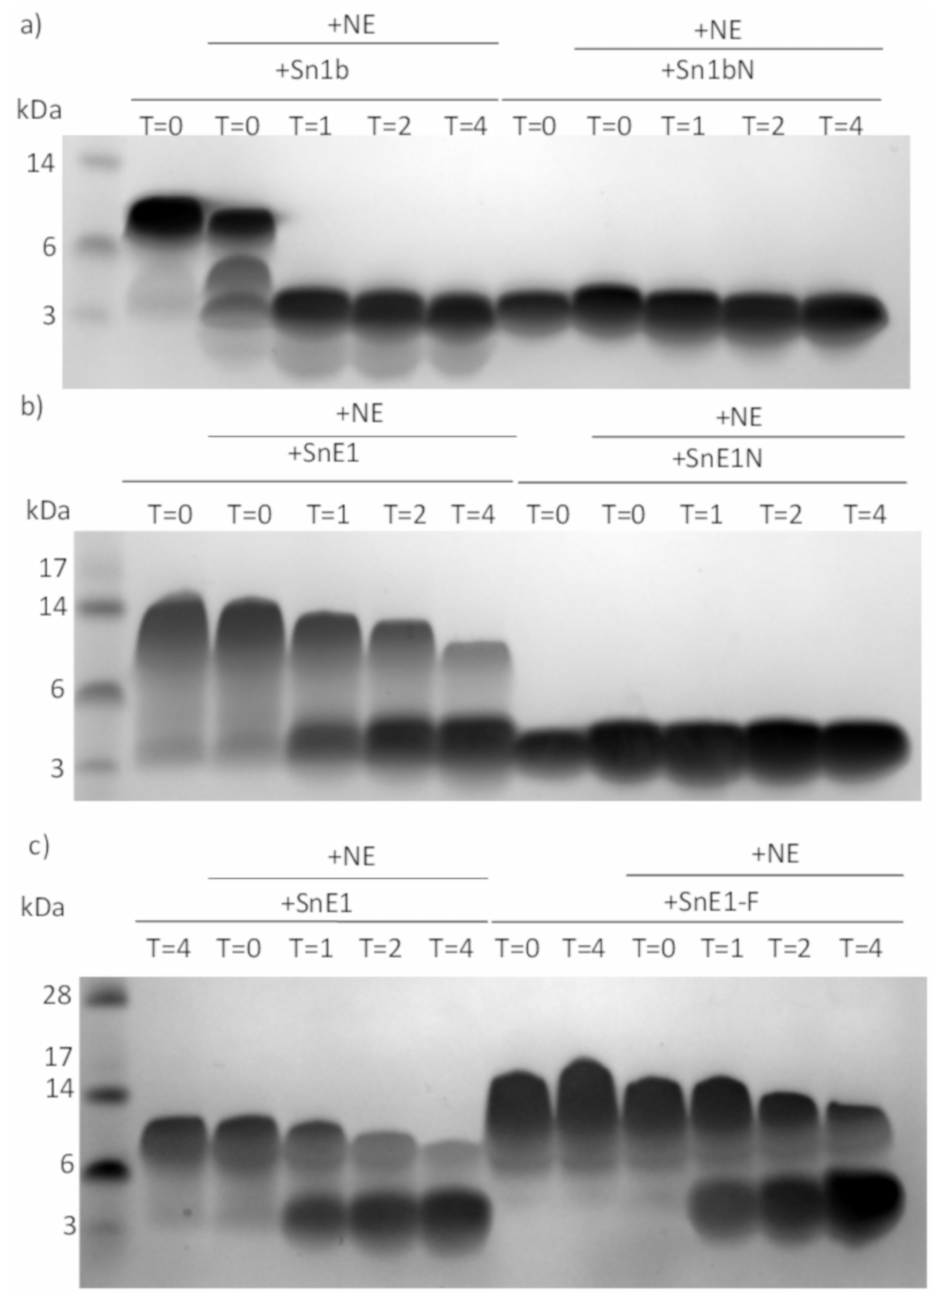
Figure 8. SDS-PAGE gels of next generation derivative peptides following incubation with NE. ( a ) Sn1b, Sn1bN (160 µ M), ( b ) SnE1, SnE1N (120 µ M) ( c ) SnE1 and SnE1-F (120 µ M) were incubated